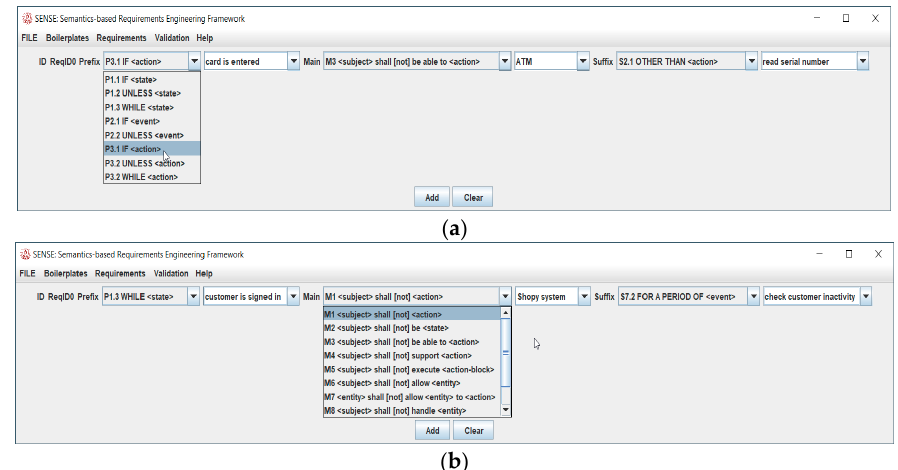
Figure 7. Validation statistics in ATM and Shopy use cases. Figure 6. ( a ) Part of SENSE GUI—Boilerplate (ATM use case); ( b ) part of SENSE GUI—Boilerplate (Shopy use case).